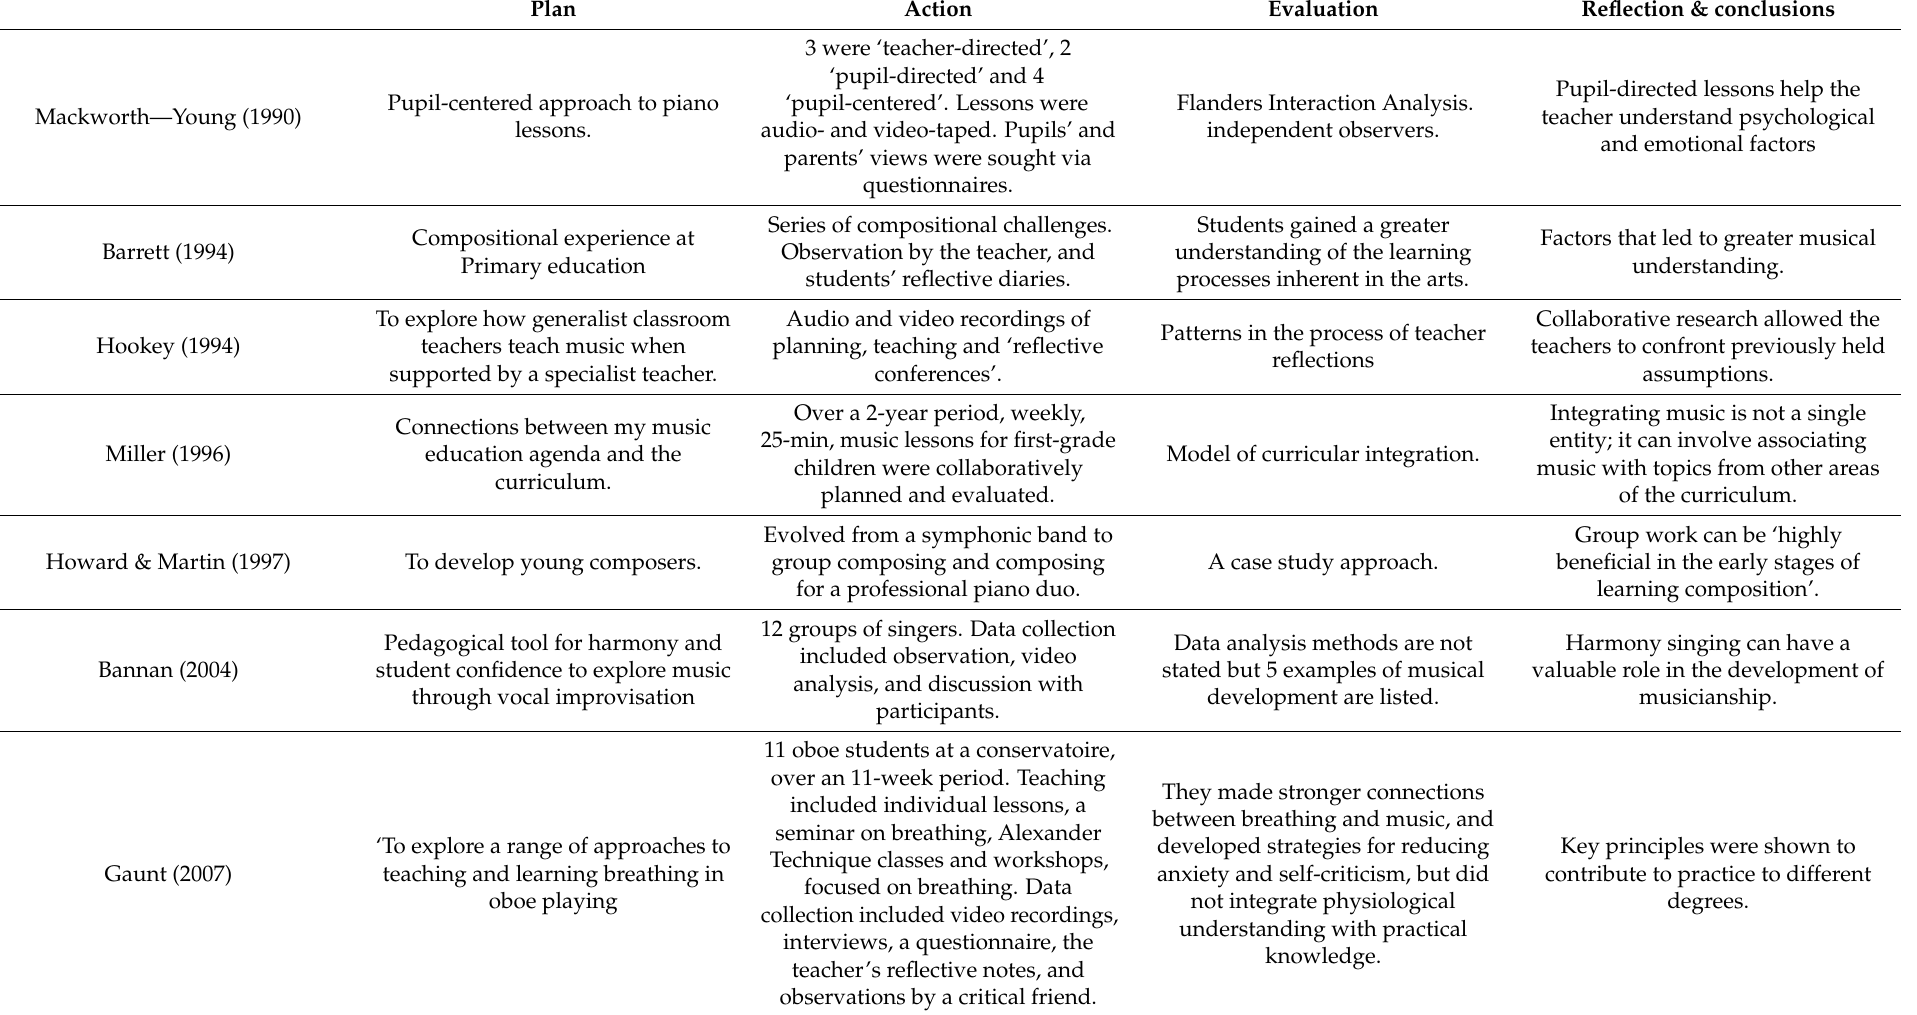
Table 1. Examples of action-research researches in music education. Based on Cain (2008)